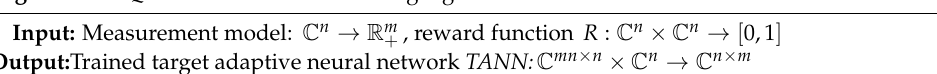
Algorithm 1: Quasi-reinforcement learning algorithm for